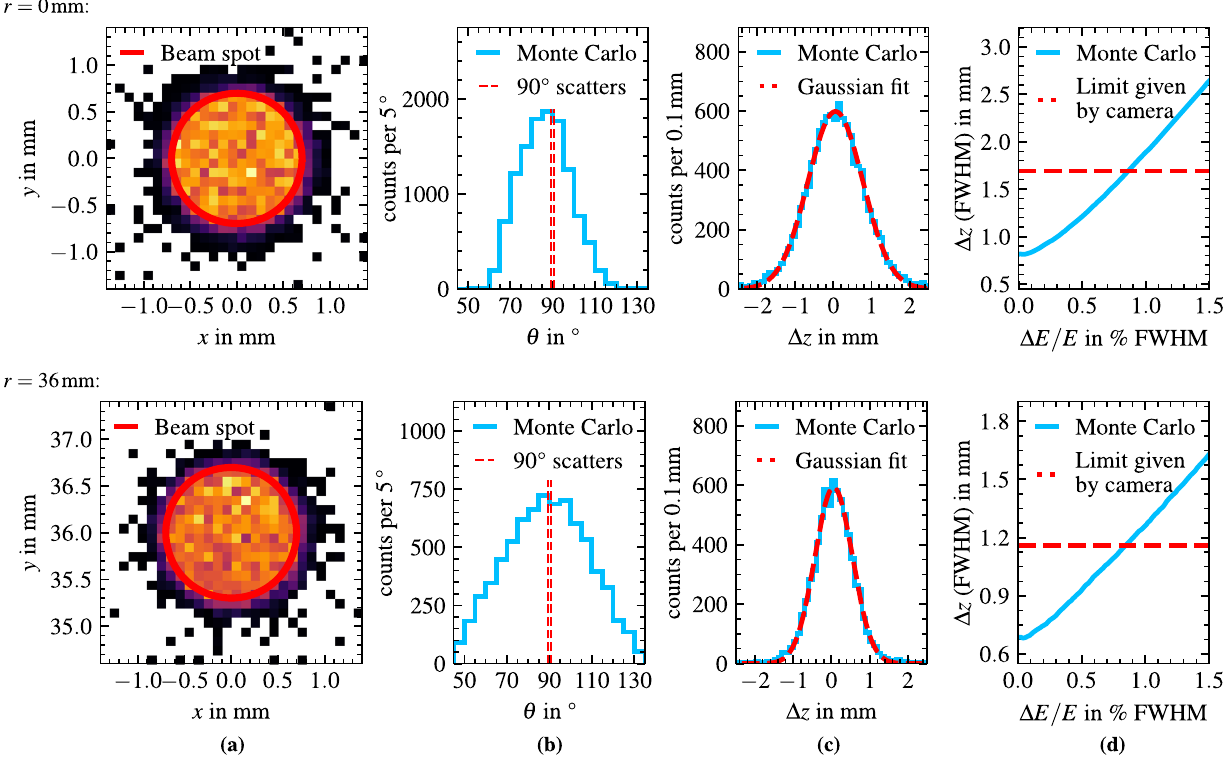
Fig. 5 a Beam spot profile as determined from a Monte Carlo simula- tion performed with the simulation toolkit Geant4 [42]. b Distribution of Compton angles, θ , of Monte Carlo events with only one Comp- ton scatter in the germanium detector. Shown as a dashed band is the angle range of perpendicularly scattered gammas, θ = ( 90 . 00 ± 0 . 72 ) ◦ , expected for a 80mm long and 1mm wide collimator slit and perfect collimation. c Deviation, Δ z , of the reconstructed z θ using Eq.(2) from the true z in the simulation using the energy and spatial resolutions from